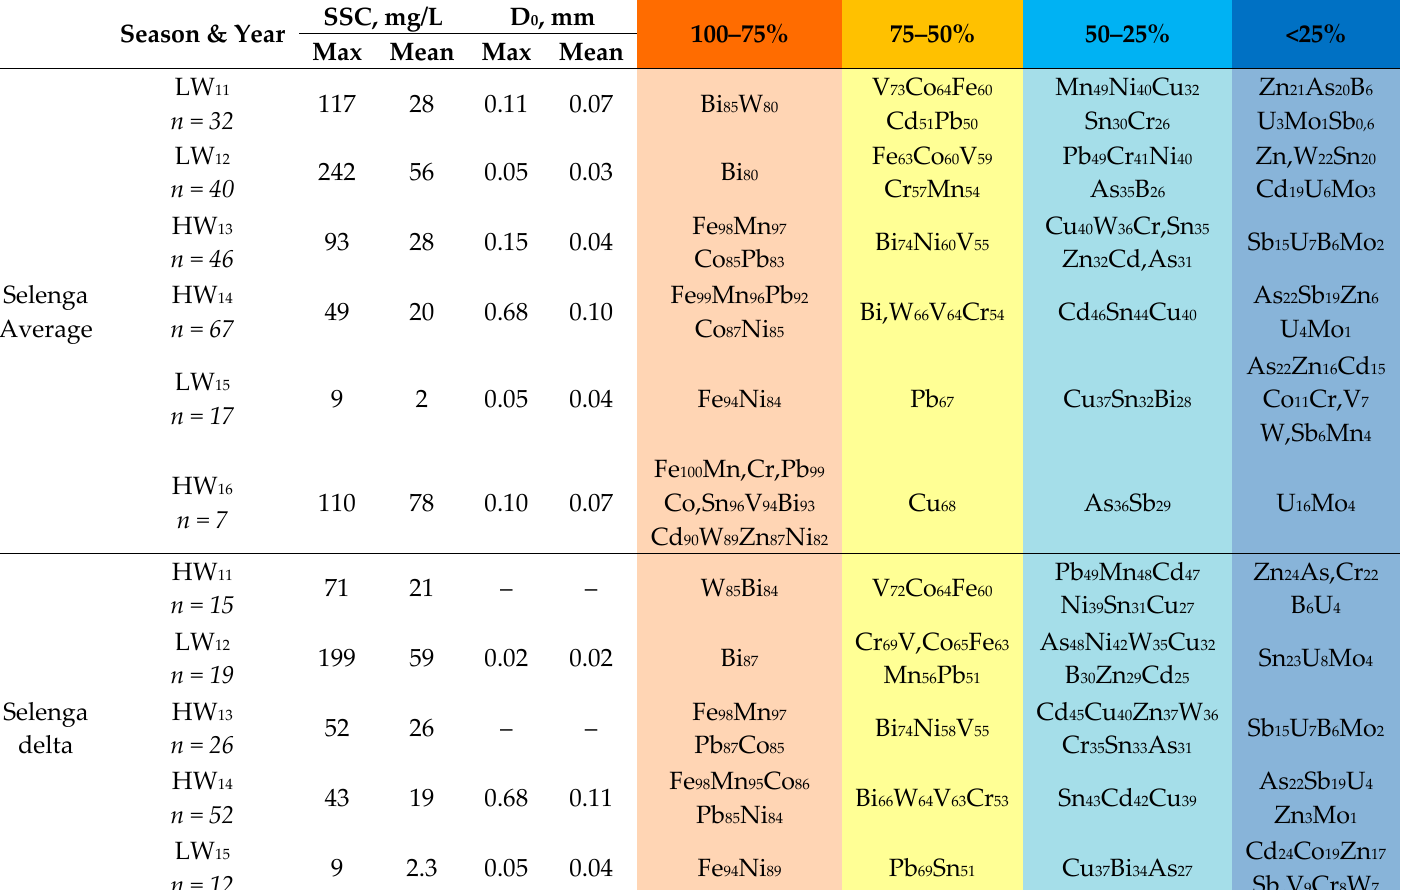
Table 1. Metal partitioning in the Selenga River (median values).